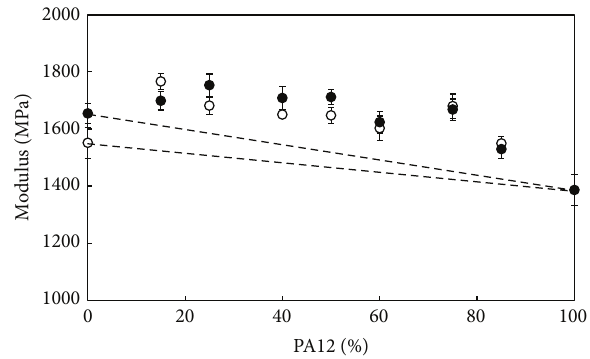
Figure 4: Young’s modulus of the uncompatibilized PP/PA12 ( I ) and compatibilized gPP/PA12 ( e ) blends, as a function of the PA12 content.